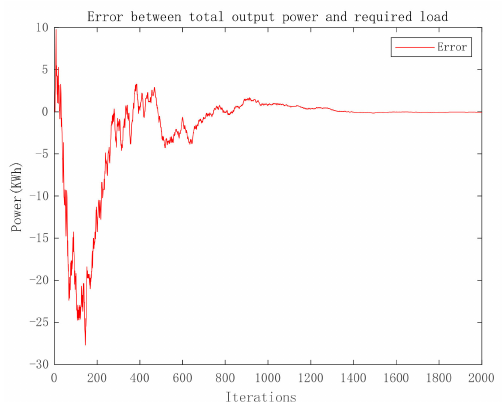
Figure 10. The error between total output power and required load.